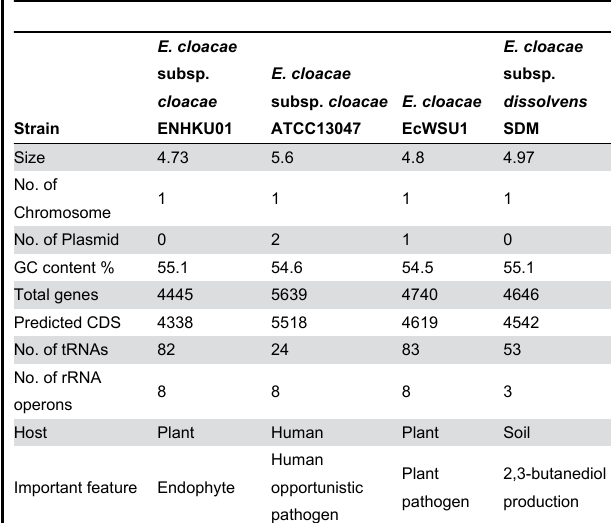
Table 1. Summary of genome sequence projects of E. cloacae .